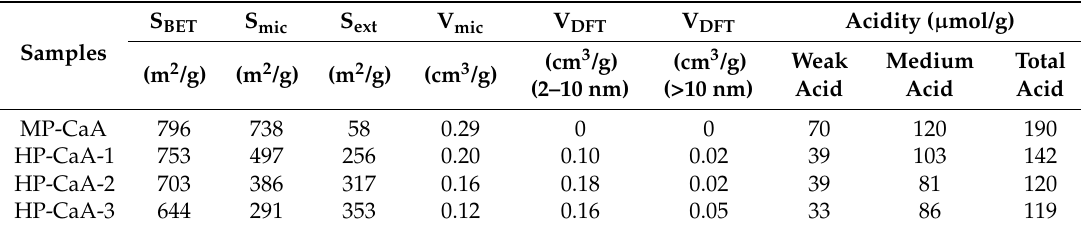
Figure 3. ( A ) N 2 adsorption–desorption isotherms; ( B ) Non-Local Density Functional Theory (NLDFT) pore size distribution; ( C ) the cumulative pore volume of zeolite CaA samples. Table 1. Pore structure parameters and acidity of CaA samples. Table 1. Pore structure parameters and acidity of CaA